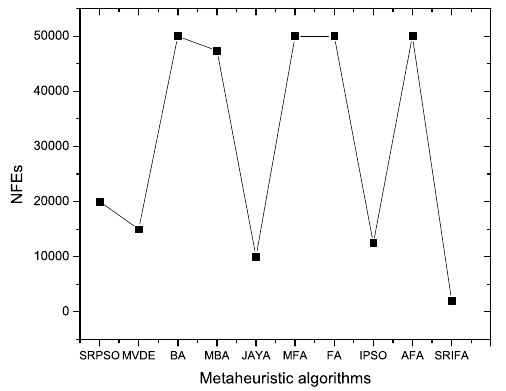
Figure 7. NIAs with NFEs for welded-beam problem.